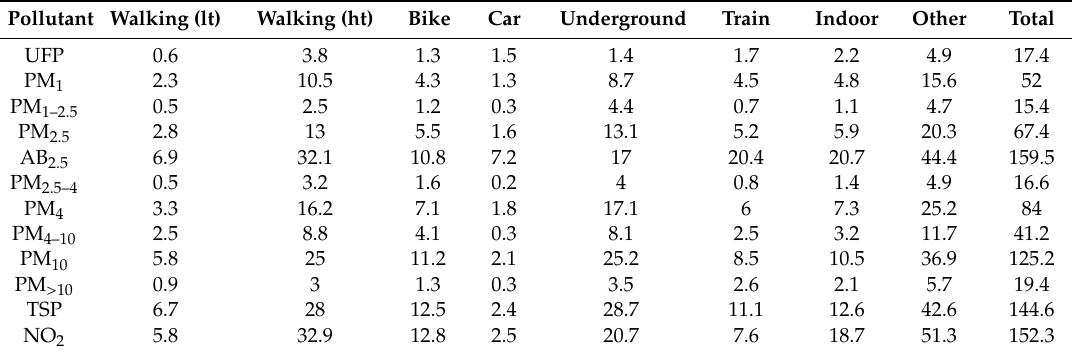
Table 3. Descriptive of the inhaled dose ( µ g) or airborne pollutants, reported as an average for each microenvironment and as total